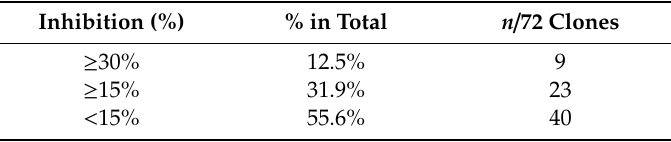
Table 1. Classification of functional scFv